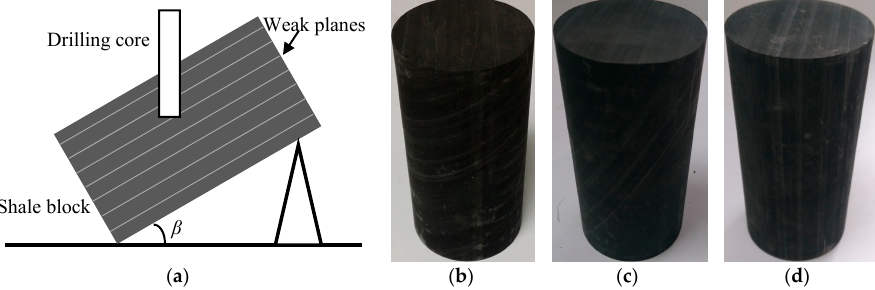
Figure 1. ( a ) Sketch of sample coring method (modified from [39]); and ( b – d ) Shale samples with different oriented weak planes (( b ) β = 30 ° , ( c ) β = 60 ° , and ( d ) β = 90 °) .